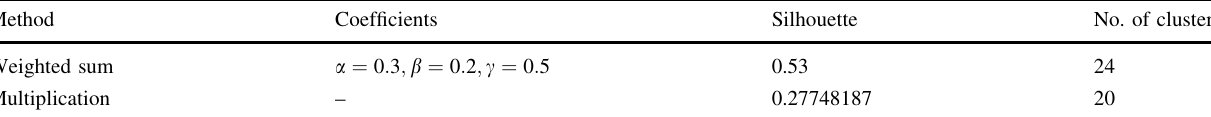
Table 2 Comparison of metrics